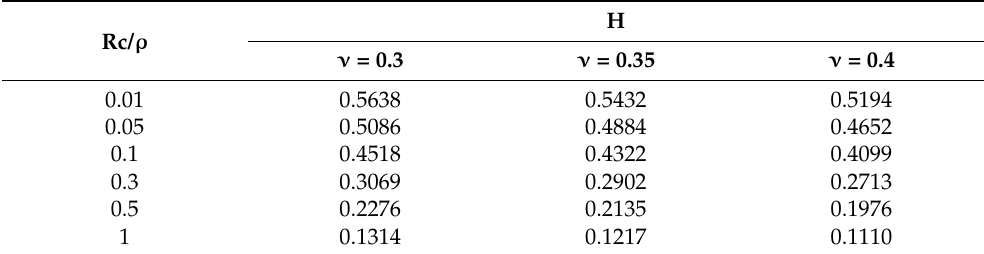
Table 1. Some values of the H function for U-shaped notches [23].